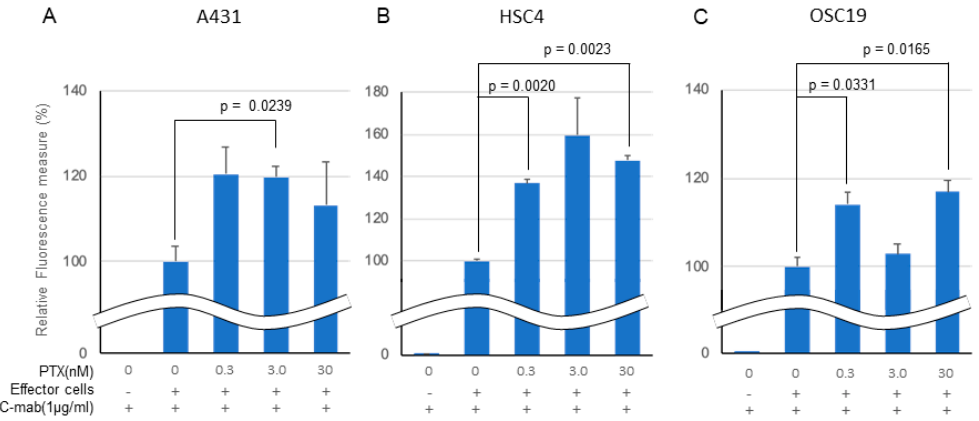
Figure 3. Effect of PTX on antibody-dependent cell-mediated cytotoxicity. Relative fluorescence to C-mab plus effector cells with gradient PTX concentration are shown. ( A ) A431, ( B ) HSC4, ( C ) OSC19. C-mab concentration was fixed to 1.0 µg/mL and 75,000 effector cells was added to induce ADCC. Double waved line indicates the contraction. Statistical analysis was performed by one-way ANOVA with Student’s t -test as a post hoc analysis, p values are indicated. The values shown are the mean of three determinations; bars: standard error of the mean. The data shown is a representative from three independent experiments with similar results.